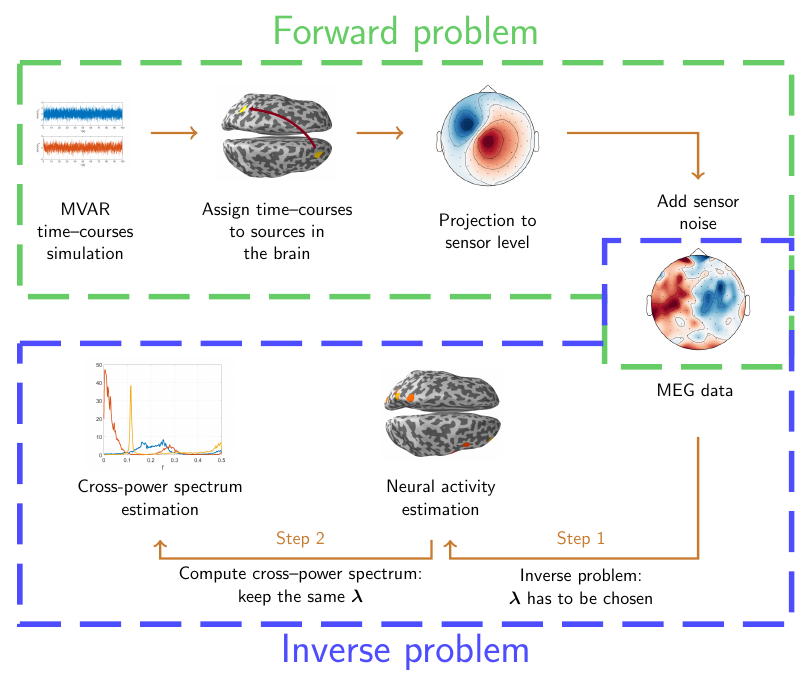
Figure 2. Real and imaginary part of the cross–power spectra of three simulated time series. Higher values of spectral complexity correspond to more peaked spectra.